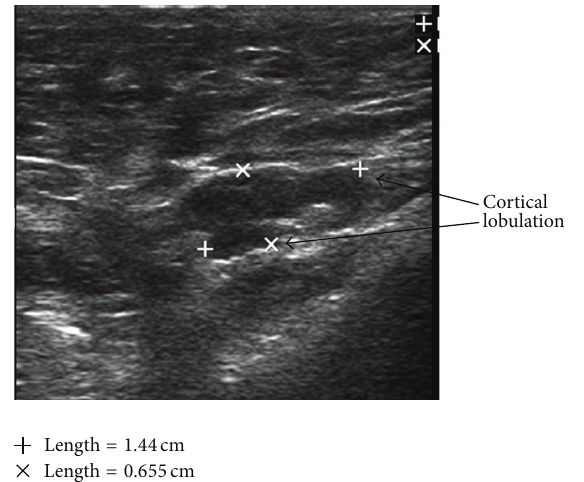
Figure 6: Highly suspicious node: enlarged node, cortical lobula- tion, and displacement of fatty hilum.